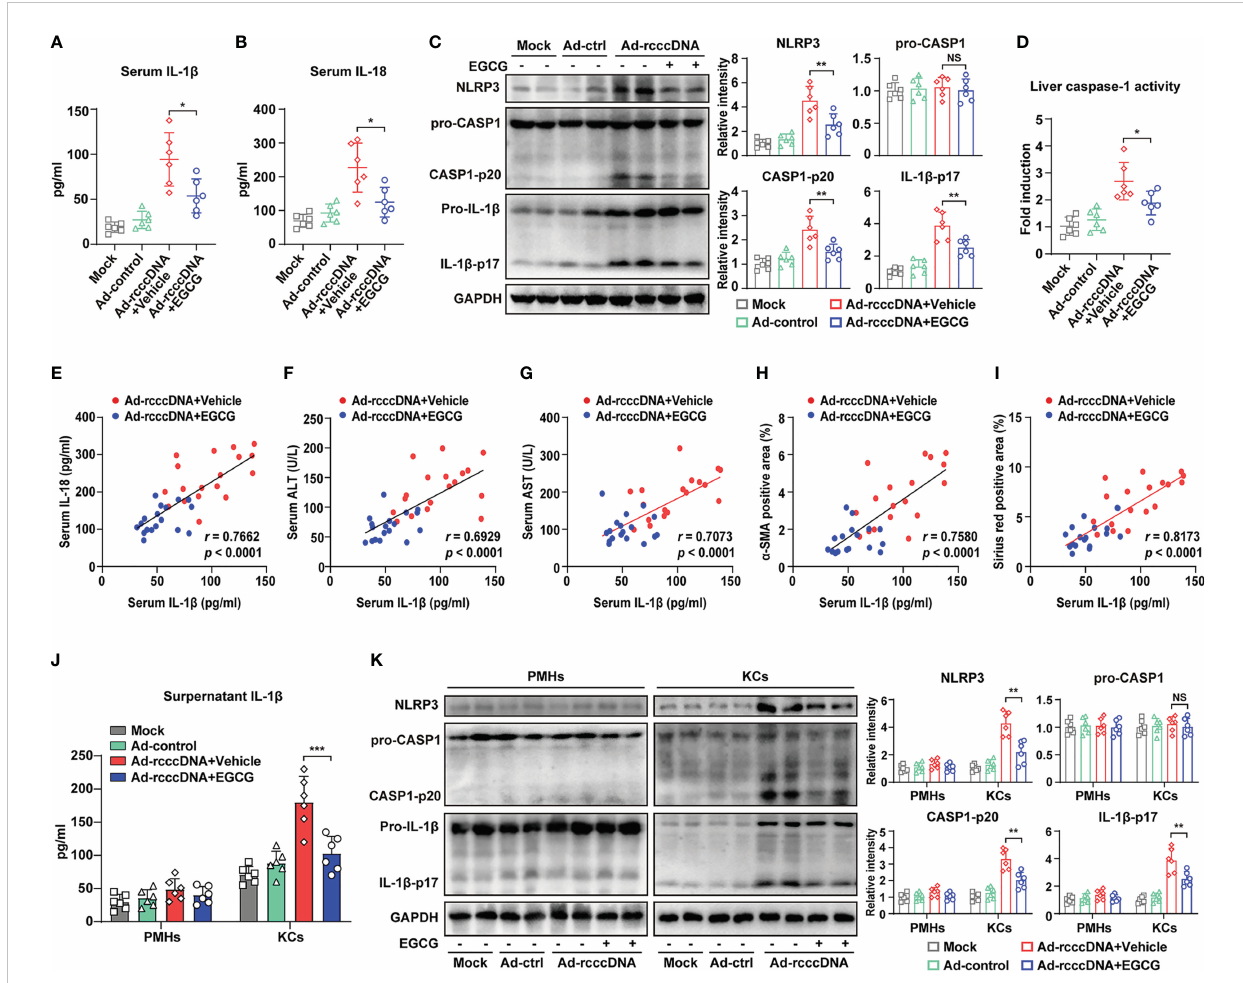
FIGURE 2 EGCG suppresses the macrophage NLRP3 in fl ammasome activation in HBV-induced liver injury and fi brosis mouse model. (A, B) IL-1 b and IL-18 levels in the sera of mock mice, Ad-control mice and rcccDNA mice treated with or without EGCG ( n = 6) were determined by ELISA. (C) Protein levels of NLRP3, pro-caspase-1, caspase-1 p20, pro-IL-1 b and IL-1 b p17 in liver tissues were determined by Western blotting. Relative levels of NLRP3, pro-caspase-1, caspase-1 p20 and IL-1 b p17 were determined by densitometric analysis, and the value from control group was set at 1.0. (D) Liver caspase-1 activity of liver tissues was determined by caspase-1 activity assay. (E) Correlation analysis of serum IL-1 b with serum IL-18. (F – I) The correlations of serum IL-1 b with serum ALT, serum AST, liver a -SMA positive area, and liver Sirius red positive area in rcccDNA mice treated with or without EGCG. (J, K) PMHs and KCs were isolated from mock mice, Ad-control mice and rcccDNA mice treated with or without EGCG, followed by the determination of NLRP3 in fl ammasome activation in PMHs and KCs ( n = 6). Supernatant IL-1 b levels were determined by ELISA (J) . Protein expression levels of NLRP3, pro-caspase-1, cleaved caspase-1 p20, pro-IL-1 b , and cleaved IL-1 b p17 were determined by Western blotting as in C (K) . Data are shown as means ± SEM and compared by unpaired Student ’ s t-test. *P < 0.05, ** P < 0.01, *** P < 0.001. NS, no signi fi